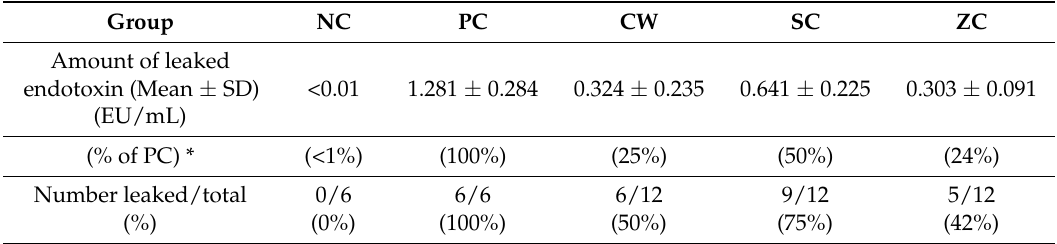
Table 1. The mean amount of endotoxin leakage (EU/mL) and ratio of the leaked specimens measured after 21 days of exposure for the experimental groups and control groups.